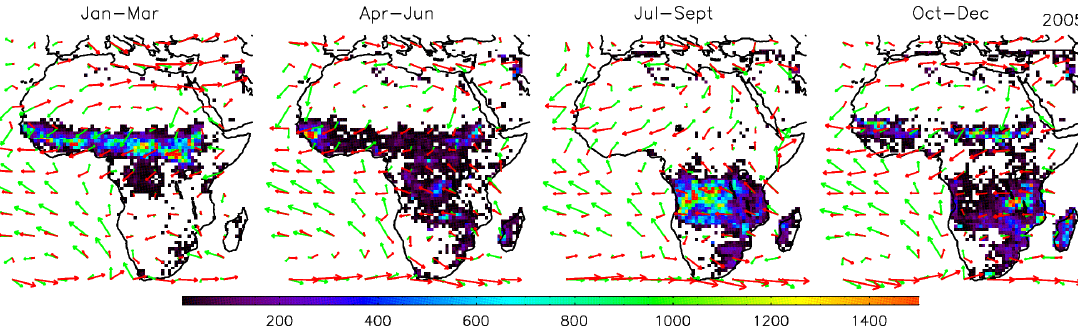
Fig. 2. Maps of fire occurrence for 2005, according to MODIS Active Fire Product. Colour-scale represents the number of active fires detected during each time period, at a nominal resolution (at nadir) of 1km, within a 1 ◦ × 1 ◦ grid box. Wind fields at 950 (green) and 750 (red) hPa (corresponding approximately to 600m and 2.5km of altitude) for 2005 are over-plotted on the figure. Seasonal wind maps are obtained from monthly averaged data provided by the European Center for Medium-Range Weather Forecasts (ECMWF). Arrows indicate the direction and intensity of the mean wind at that point. Wind speed is expressed in degrees per day so that arrow’s length shows the distance travelled by the air in 24h.